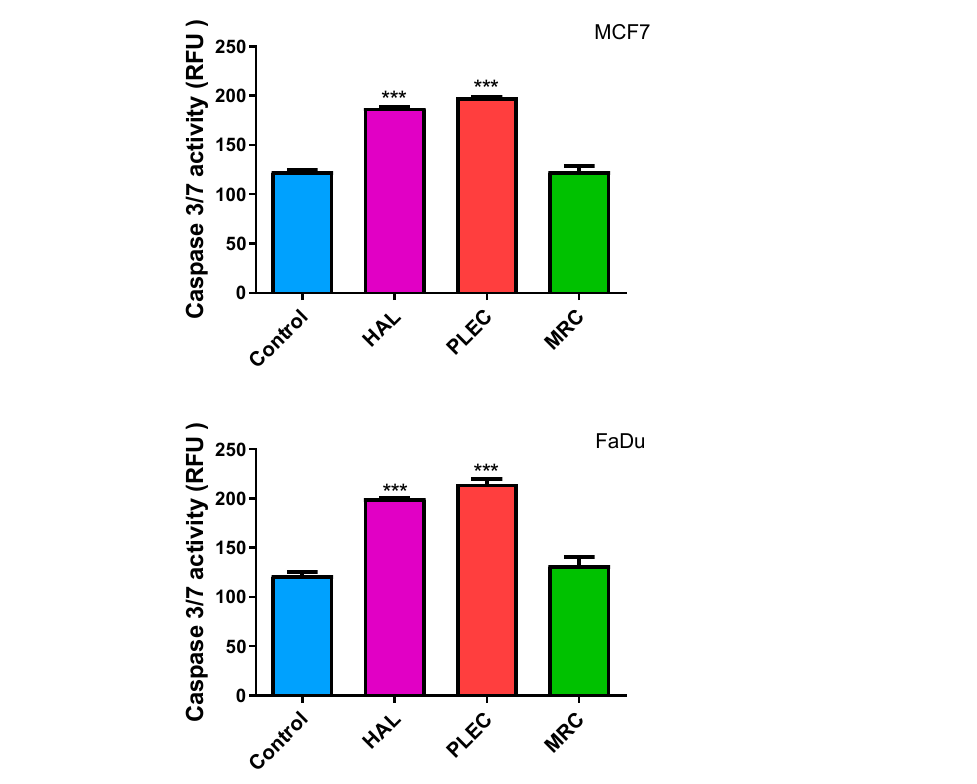
Figure 10. Action of HAL, PLEC and MRC on Caspase-3/-7 activity levels. MCF7 and FaDu cells were treated with appropriate compounds for 24 h, stained with 5 µM CellEvent™ Caspase-3/-7 Green detection reagent for 30 min at 37 °C and fluorescence immediately measured. Data represents the mean ± SD of three replicates. *** ( p < 0.001) vs. untreated (control) cells.